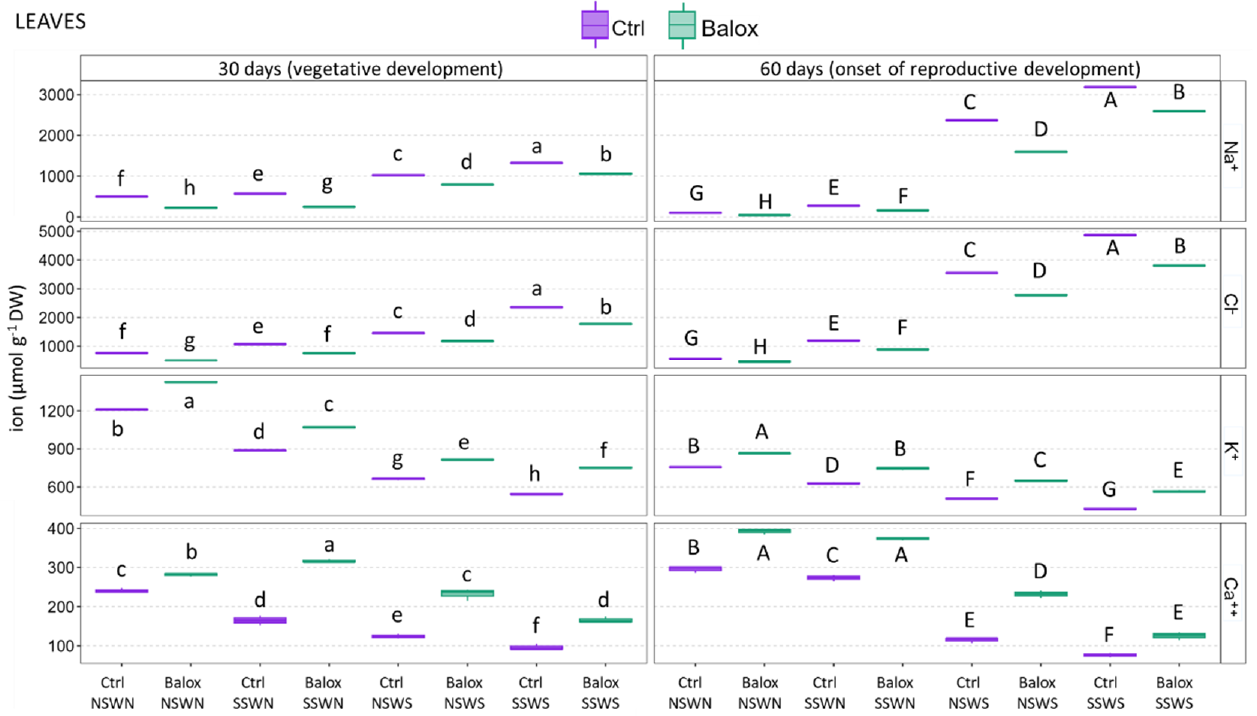
Figure 7. Ion contents in leaves: sodium (Na + ), chloride (Cl − ), potassium (K + ), and calcium (Ca 2+ ) in tomato plants subjected to increasing salinity by different combinations of saline or non-saline soil and irrigation water; the plants were treated, or not, with the biostimulant containing polyphenols at 1.4% ( w / w ) and glycine betaine at 3.0% ( w / w ) at a dose of 0.4 mL L −1 of irrigation water. The control treatments without biostimulant (Ctrl) and with biostimulant (BALOX ® ) are defined as follows: (i) NSWN: Non-saline soil (EC = 2.28 dS/m) and non-saline water (EC = 0.91 dS/m); (ii) SSWN: Saline soil (EC = 8.55 dS/m) and non-saline water (EC = 0.91 dS/m); (iii) NSWS: Non-saline soil (EC = 2.28 dS/m) and saline water (EC = 10.50 dS/m); (iv) SSWS: Saline soil (EC = 8.55 dS/m) and saline water (EC = 10.50 dS/m). The evaluation periods: 30 days and 60 days of treatments. The values are the means ± SE ( n = 3). Different letters above the bars (lowercase for 30 days and capital for 60 days of treatments) indicate significant differences between treatments, according to the ANOVA test ( p < 0.05). Statistical analyses were performed independently for the two treatment periods.